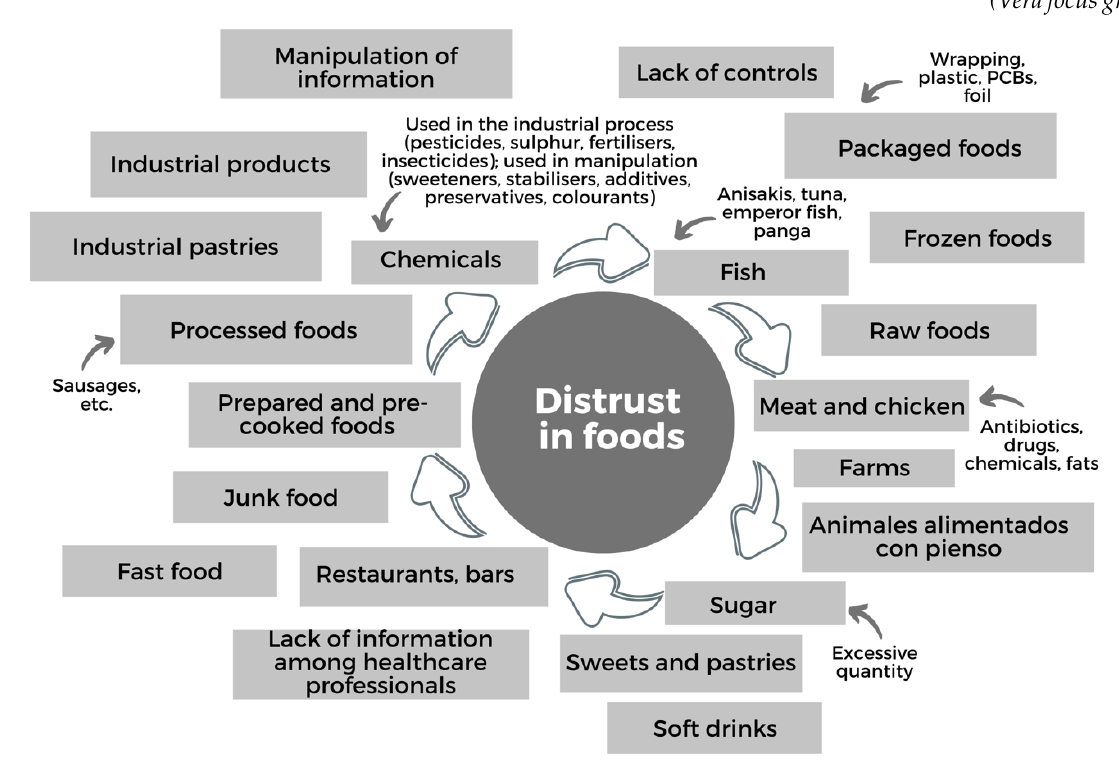
Figure 5. Categories and items arising from the focus groups in relation to distrust in food.